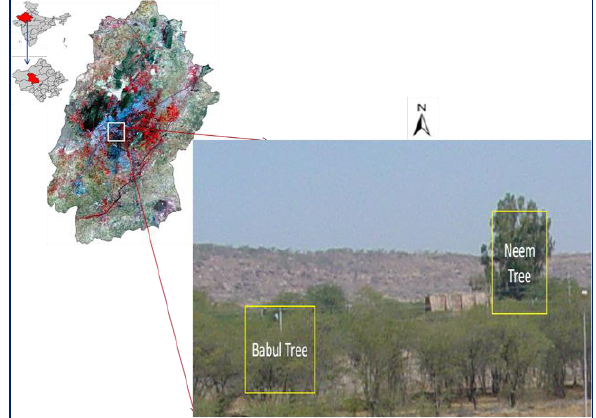
Fig. 1. Map of the Study